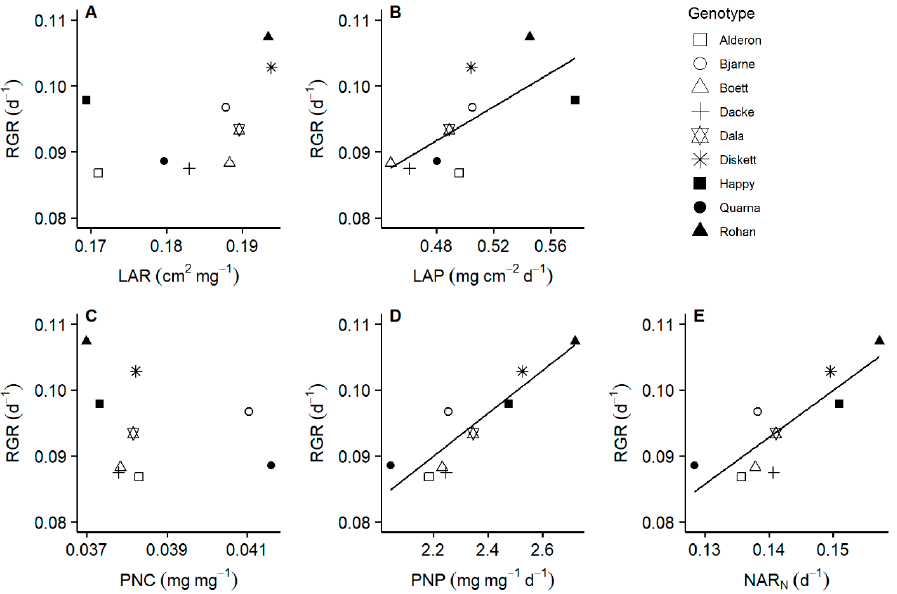
Figure 2. Relative growth rate of whole plant biomass and its driving variables for nine spring wheat genotypes. Relative growth rate (RGR) was calculated using the whole plant biomasses at days 1 and 20. Leaf area ratio (LAR) and leaf area productivity (LAP) were calculated using the total leaf areas at days 7 and 20. Plant N concentration (PNC), plant N productivity (PNP) and relative N accumulation rate (NAR N ) were calculated using the N concentrations at days 1 and 20. Linear regressions: ( A ) r 2 = 0.135, p = 0.178; ( B ) r 2 = 0.416, p = 0.036; ( C ) r 2 = − 0.049, p = 0.456; ( D ) r 2 = 0.797, p < 0.001; ( E ) r 2 = 0.690, p = 0.003.